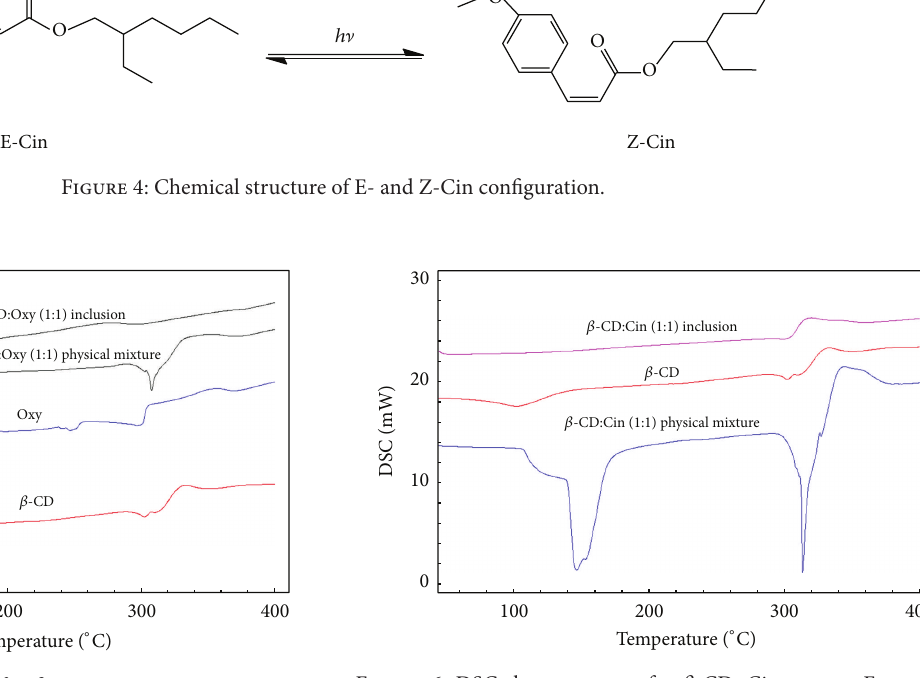
Figure 5: DSC thermograms of a 𝛽 -CD:Oxy system. From top: Oxy : 𝛽 -CD inclusion complex, physical mixture of Oxy and 𝛽 -CD, pure Oxy, and pure 𝛽 -CD.